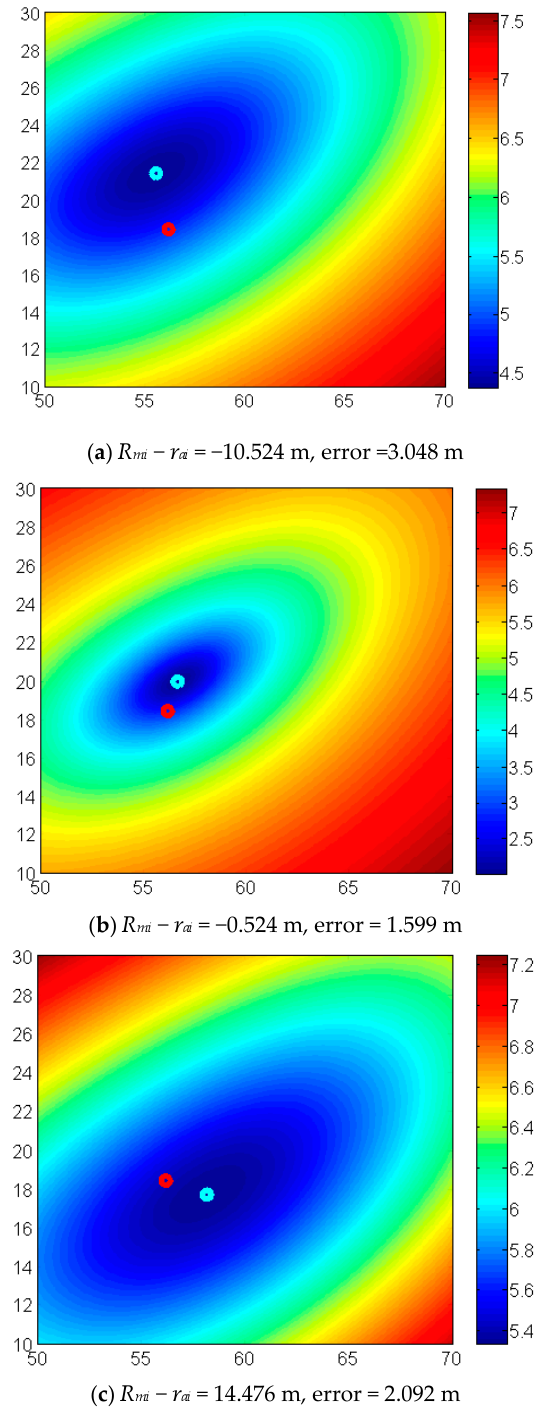
Figure 9. The contour of the logarithm of Equation (1) with different fluctuation of measurements (form 55 m to 80 m) in station #7. The error in ( a – c ) refers to location error.